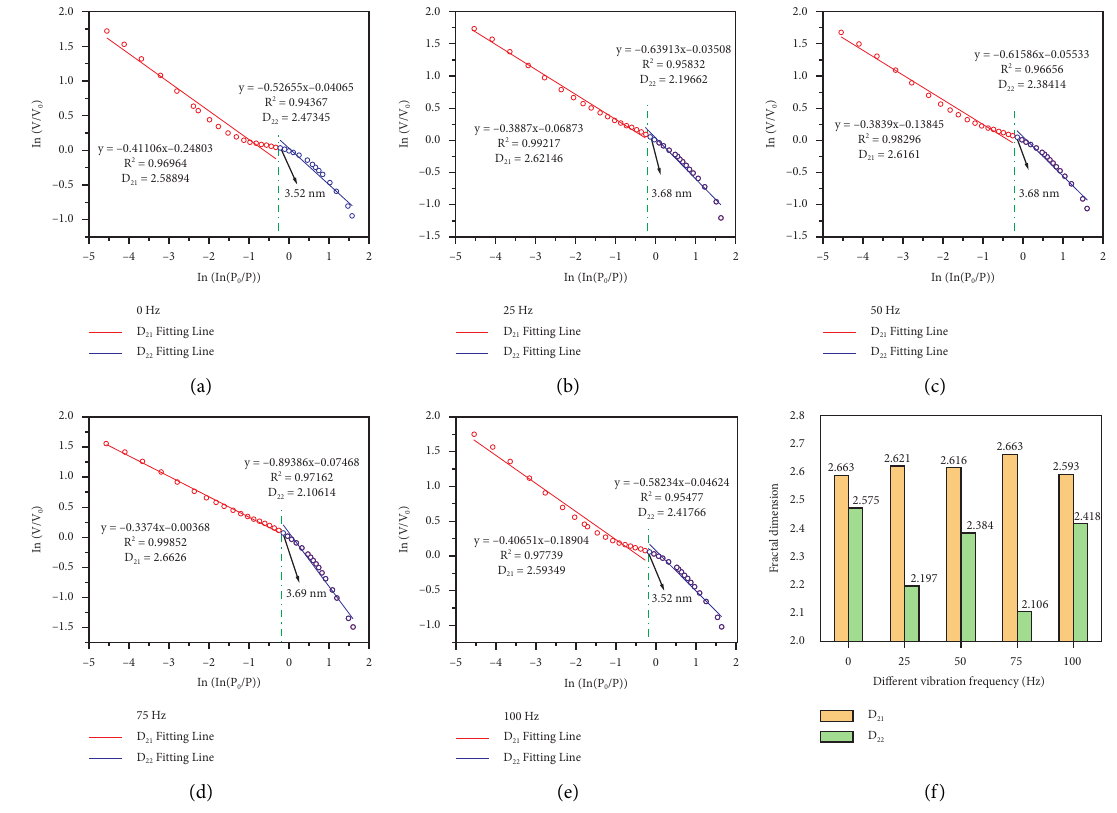
Figure 10: Fractal dimension of micropores and minipores of the VDF coal samples: (a–e) the fractal characteristics of the micropores and minipores at 0, 25, 50, 75, and 100Hz vibration-based LPNA data, respectively; (f) fractal trend of D 21 and D 22